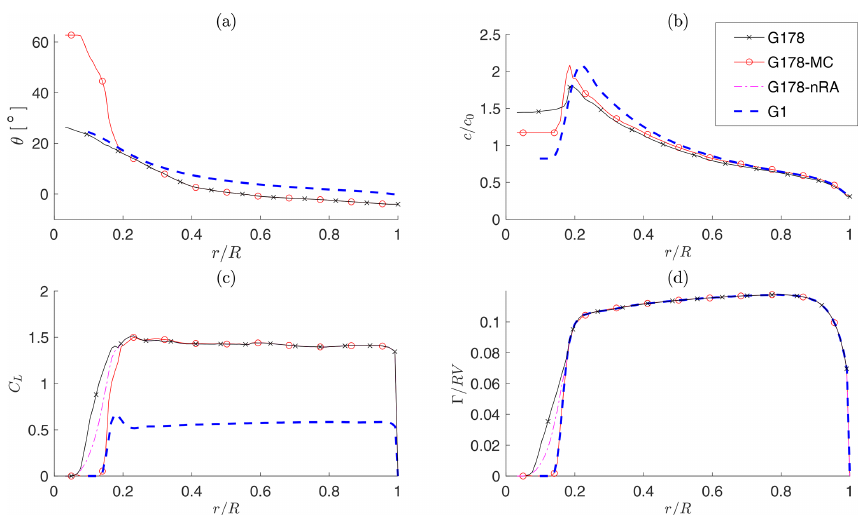
Figure 3. Distributions of twist θ (a) , non-dimensional chord c/c 0 (b) , lift coefficient C L (c) and non-dimensional circulation (cid:48)/RV (d) , for the G1 and for the G178, G178-MC and G178-nRA full-scale